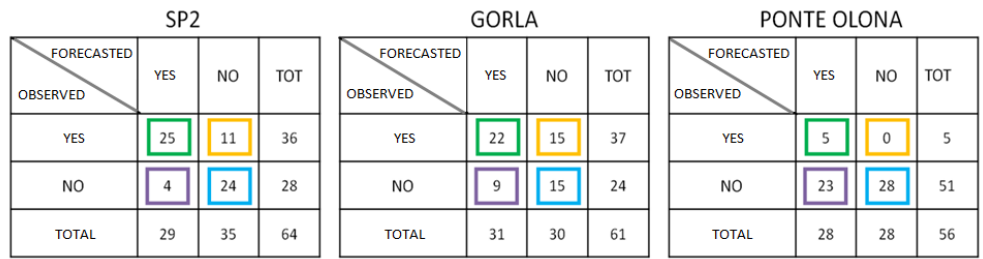
Figure 9. Contingency tables for clear sky days.